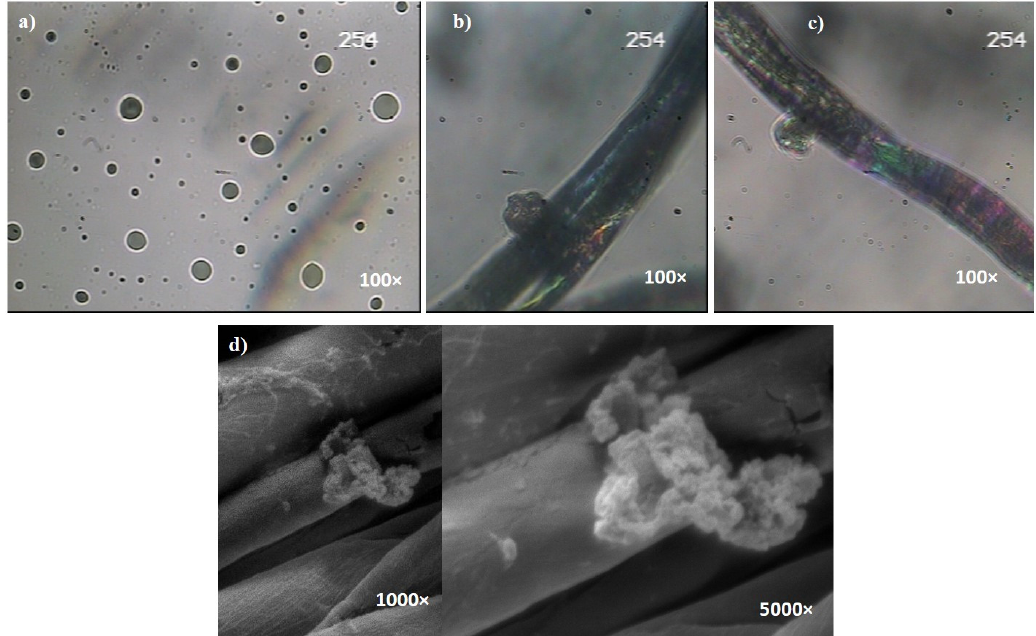
Figure 1. Optical photographs of ( a ) microcapsule solution, ( b ) microcapsules on the surface of the cellulosic fiber, ( c ) microcapsules on the surface of the cellulosic fiber after washing and ( d ) SEM images of ruptured microcapsule at different magnifications (the inset in d) is the ruptured microcapsule at 1000× magnification).